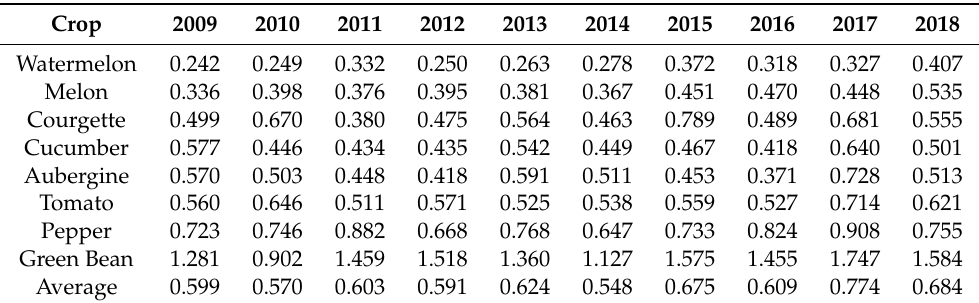
Source: Own elaboration made with data provided by the Provincial Delegation of the Regional Department of Agriculture of the Andalusian Regional Government in Almería (Spain) (2009 to 2018) [17].